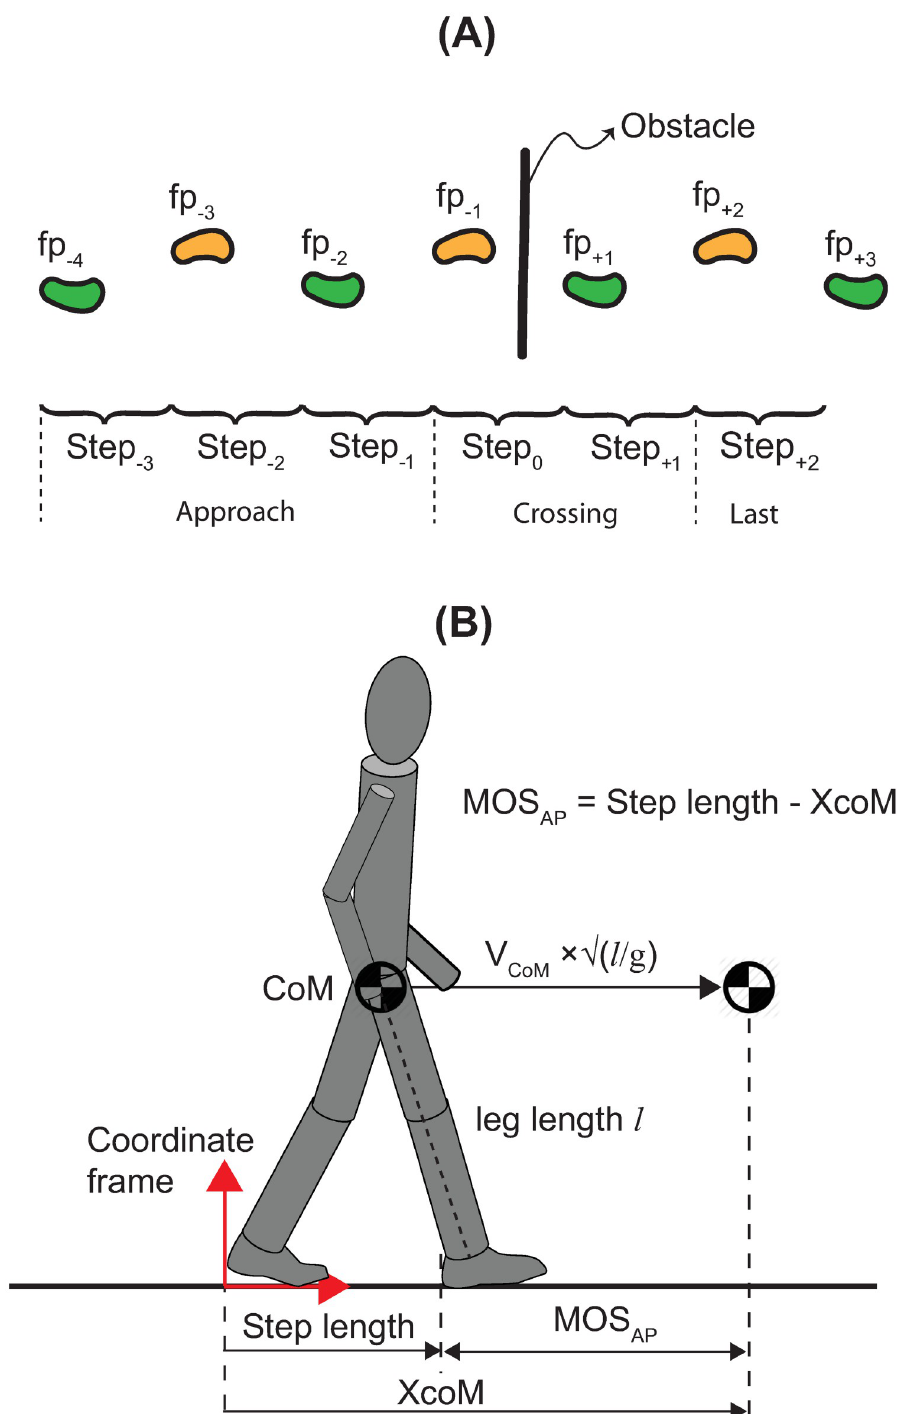
Fig 1. Experimental task and basic definitions. Illustration of foot placements while approaching (fp -4 to fp -1 ), crossing (fp +1 and fp +2 ) and after crossing (fp +3 ) the obstacle, and of steps while approaching (Step -3 to Step -1 ), crossing (Step 0 and Step +1 ) and after crossing (Step +2 ) the obstacle (A) . Definitions of the extrapolated center of mass (XcoM) and margin of stability, MOS AP . Step length, XcoM and MOS AP are computed at the moment of lead heel contact in a coordinate frame located where the rear heel contacted the ground (B)